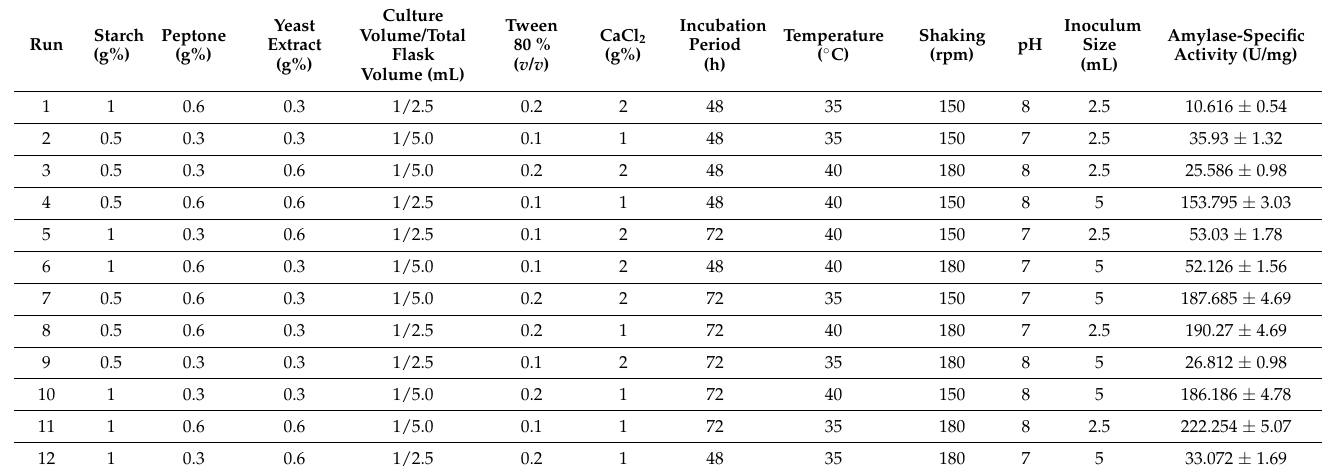
Table 4. Results of the P–BD to evaluate factors affecting alpha-amylase production by the MS009 isolate.